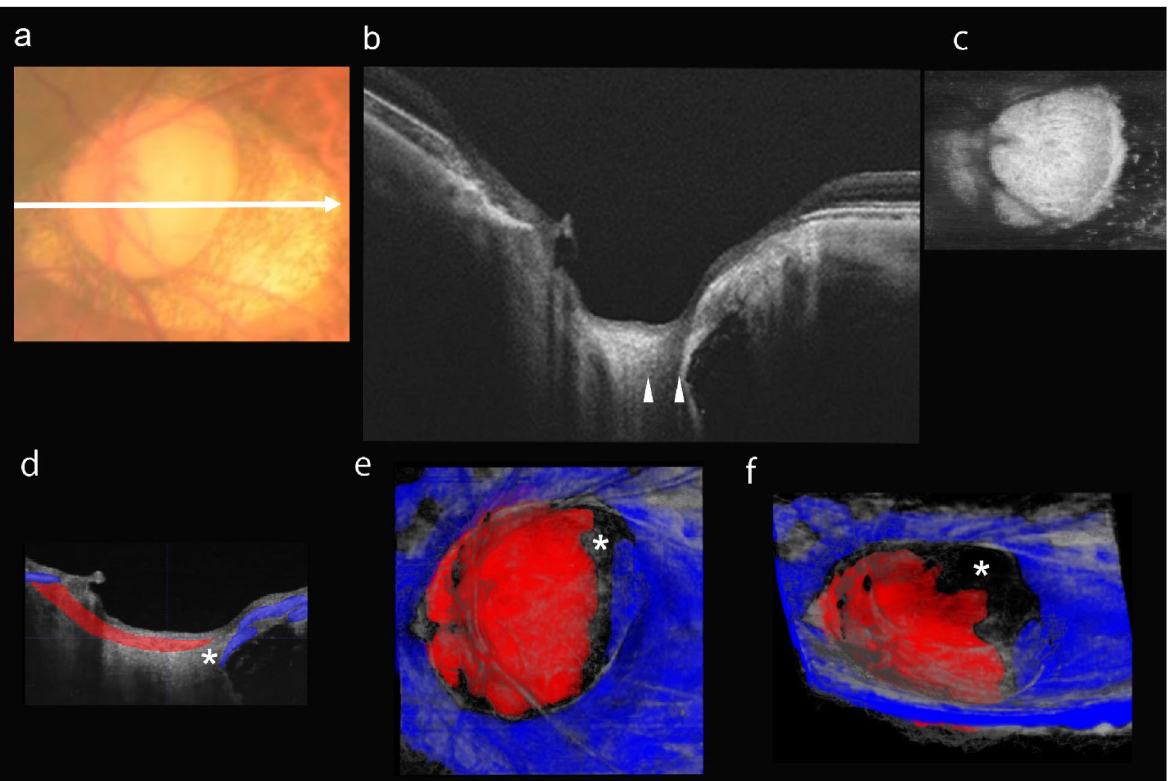
Figure 3. Color fundus photographs and OCT images of a 57-year-old highly myopic woman with an lamina cribrosa defect (LCD). ( a ) Color fundus photograph showing optic disc of the left eye. Myopic conus is present at the peripapillary area mostly temporal to the optic disc. White arrow shows scanning line of OCT images. ( b ) Horizontal OCT cross-sectional image showing the LCD. White arrowheads show the edges of the LCD. ( c ) En face OCT image of optic disc at the level of the lamina cribrosa (LC) showing that the temporal part of LC has lower reflectivity than the other parts of the LC. The temporal edge of the LC is blurry due to the presence of a hyporeflective area. ( d ) Height adjusted OCT image as (b) with manual labels showing the PPS (blue) and LC (red). ( e,f ) 3D images generated with the trained deep convolutional neural network. ( e ) En face 3D image with asterisk indicating the defect and showing that the LCD runs vertically at the temporal edge of the optic disc. ( f ) 3D image viewed from the inferior side of the fundus with an asterisk marking the LCD and showing that the edge of the defect is